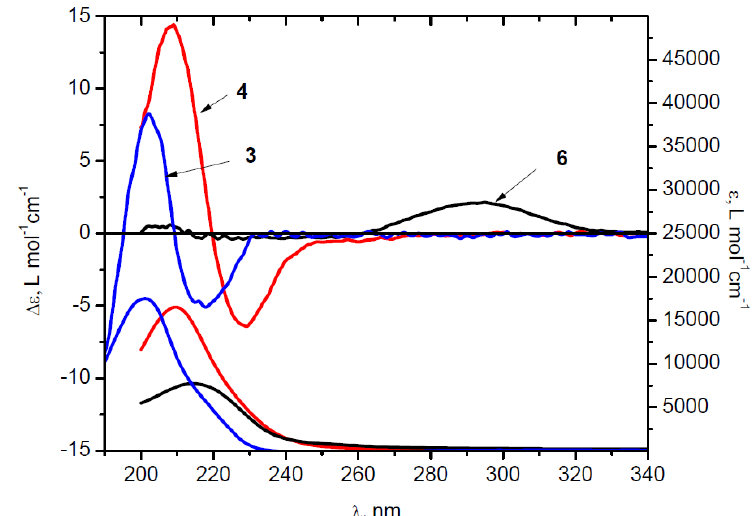
Figure 1. CD and UV spectra of dinitrile (+) - 3 (blue) in MeCN, diacid (+) - 4 (red) and ketoacid (+) - 6 (solid) in